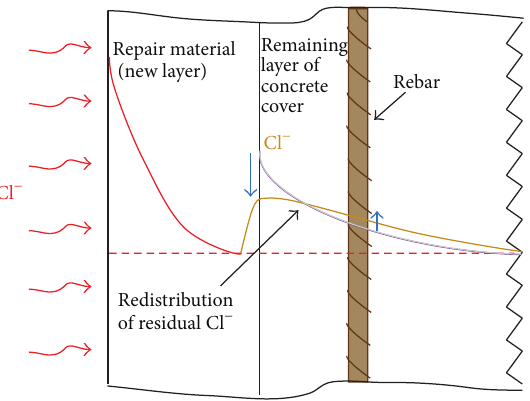
Figure 5: Chloride ingress and redistribution in a repaired concrete element (2-layer system) with residual chloride